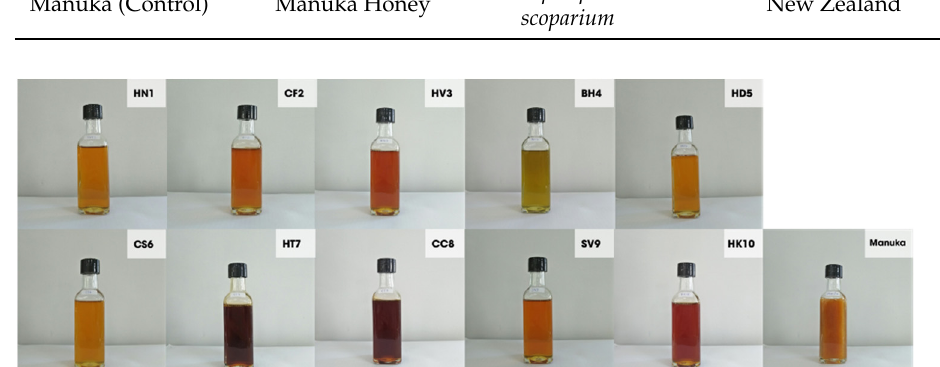
Figure 1. Colours of honey